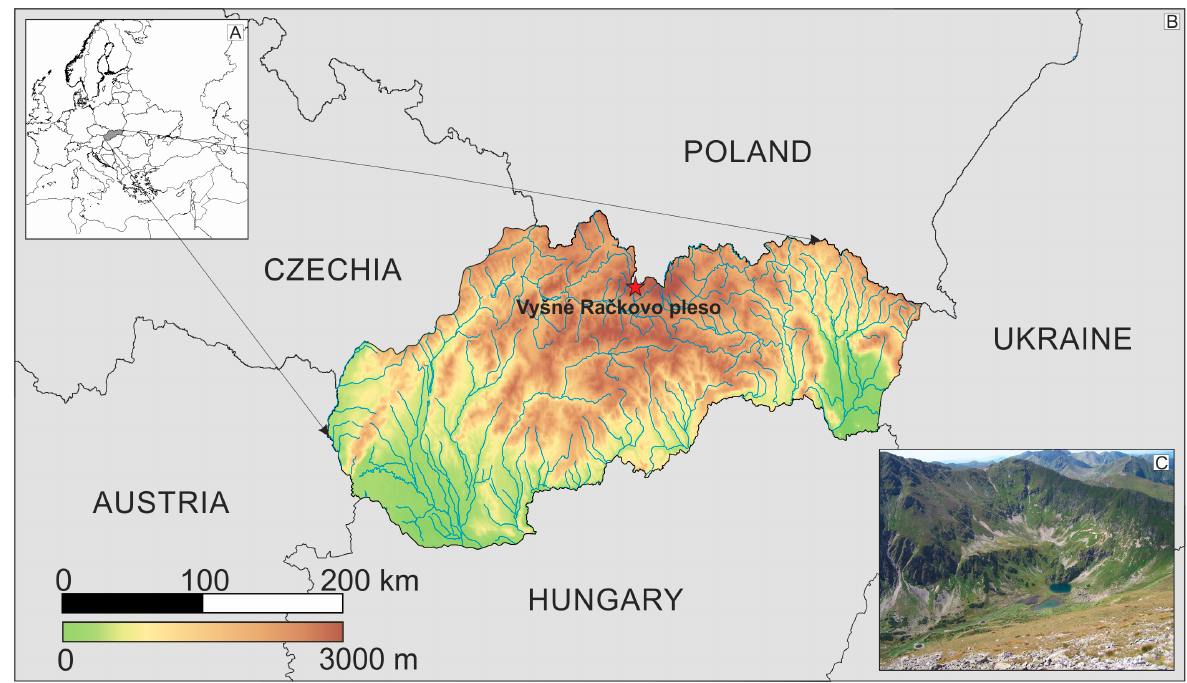
Figure 1. The location of the study lake, Vyšné Ra č kovo pleso (VRP), within Europe ( A ) and Slovakia ( B ); the photograph shows the study lake and part of itsded catchment ( C ). Data source: Database of Global Administrative Areas (GADM) and Digital Chart of the World (DCW). Photo: Opioła Table 1. Hydromorphological and physicochemical characteristics of the study lake, Vyšné Ra č kovo pleso, and its catchment [16,46]. Abbreviations: R—rocks, S—sand, O—organic matter. Conductiv- ity was measured at 20 °C.